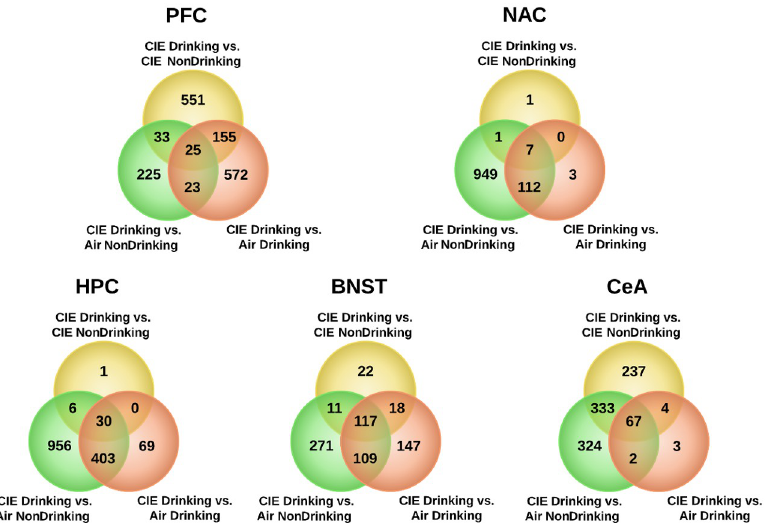
Fig 3. Overlap between 3 treatment/drinking group comparisons in all brain-regions. Overlap Venn Diagrams of differentially expressed genes in PFC, NAC, HPC, BNST, and CeA between comparison of the CIE Drinking group and either the CIE control (CIE NonDrinking), drinking control (Air Drinking), or ethanol na ï ve control (Air CIE NonDrinking). Significant differential expression: LIMMA FDR �